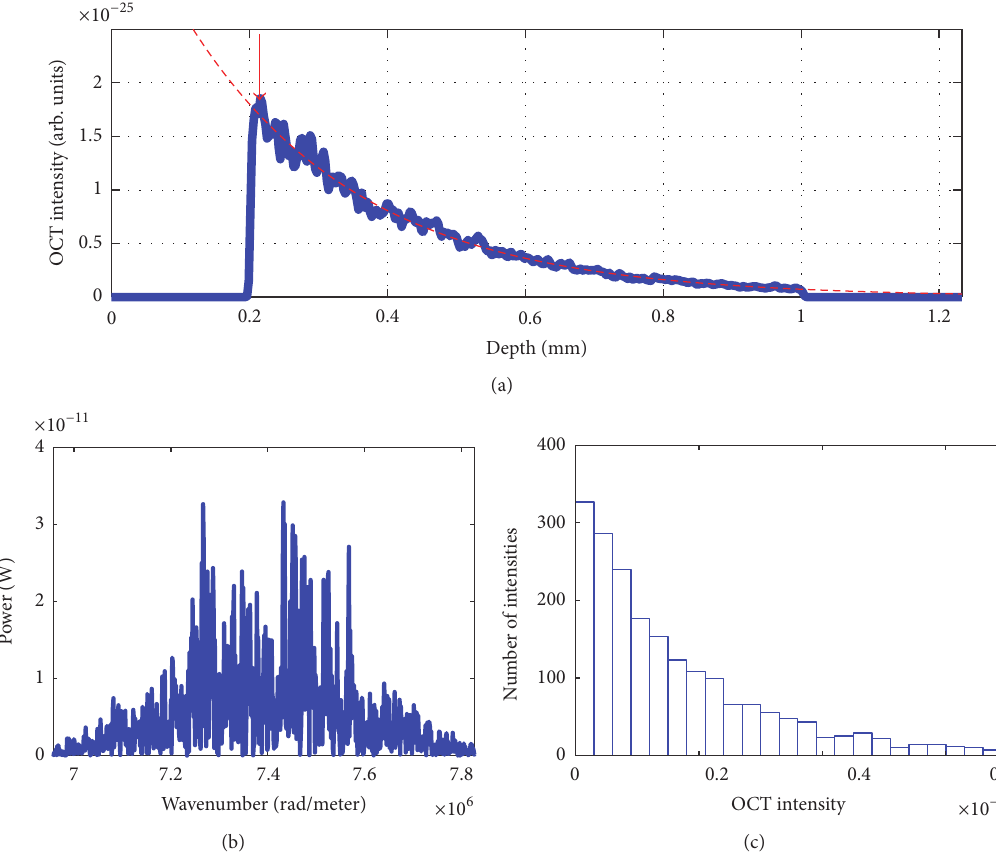
Figure9:SimulationoftheintensityOCTsignal.(a)SimulatedaverageOCTsignalindepth.Thedashedredlineindicatesthesinglescattering OCT model, and the arrow indicates the location where the distribution of the OCT signal is determined. (b) A spectrum for a single A-line simulation. (c) Distribution of OCT intensities.